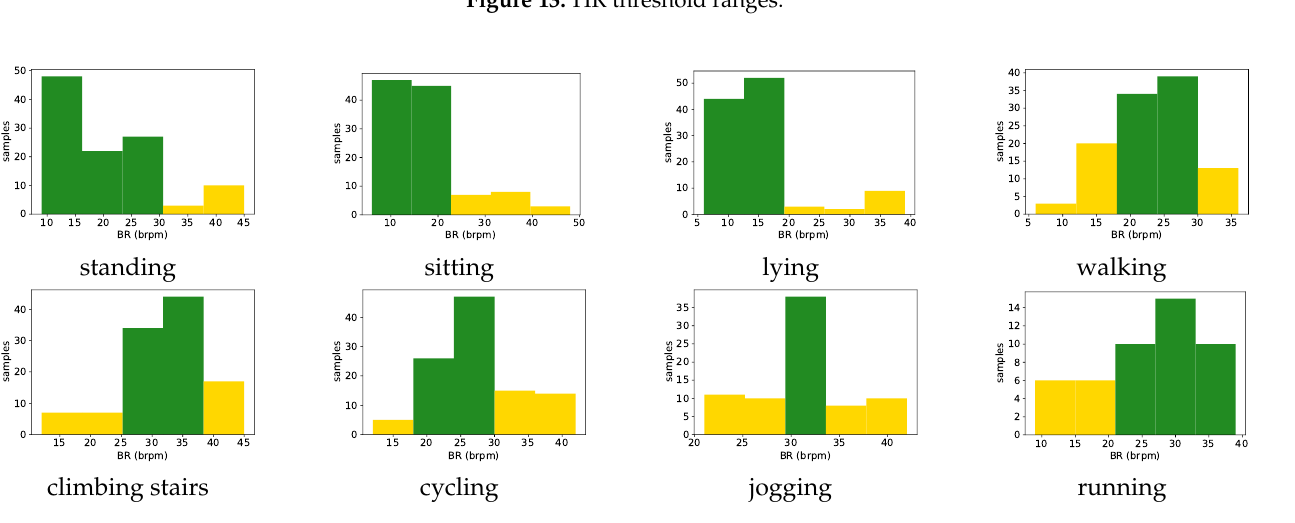
Figure 14. BR threshold ranges. Table 5. Rules’ extraction for vital signs threshold